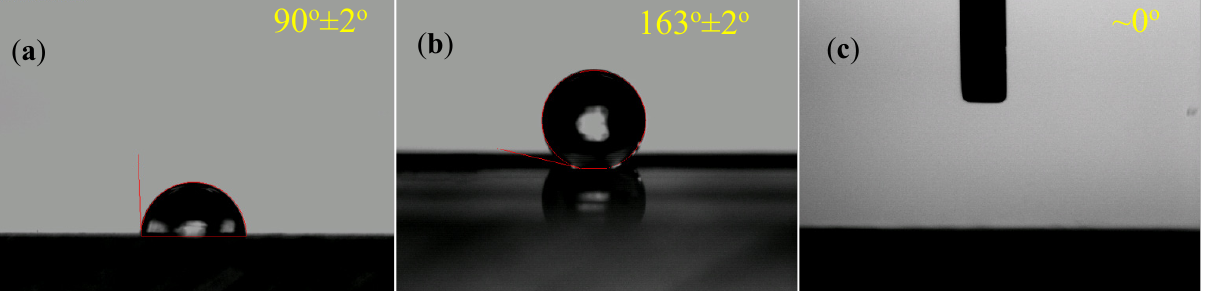
Figure 1. Water contact angle of ( a ) pristine cyclic olefin polymer (COP) surface; ( b ) COP surface treated with fluence of 30.79 J/cm 2 and power deposition rate ( PDR ) of 6.5 W/mm 2 ; and ( c ) COP surface treated with fluence of 17.60 J/cm 2 and PDR of 0.62 W/mm 2 .